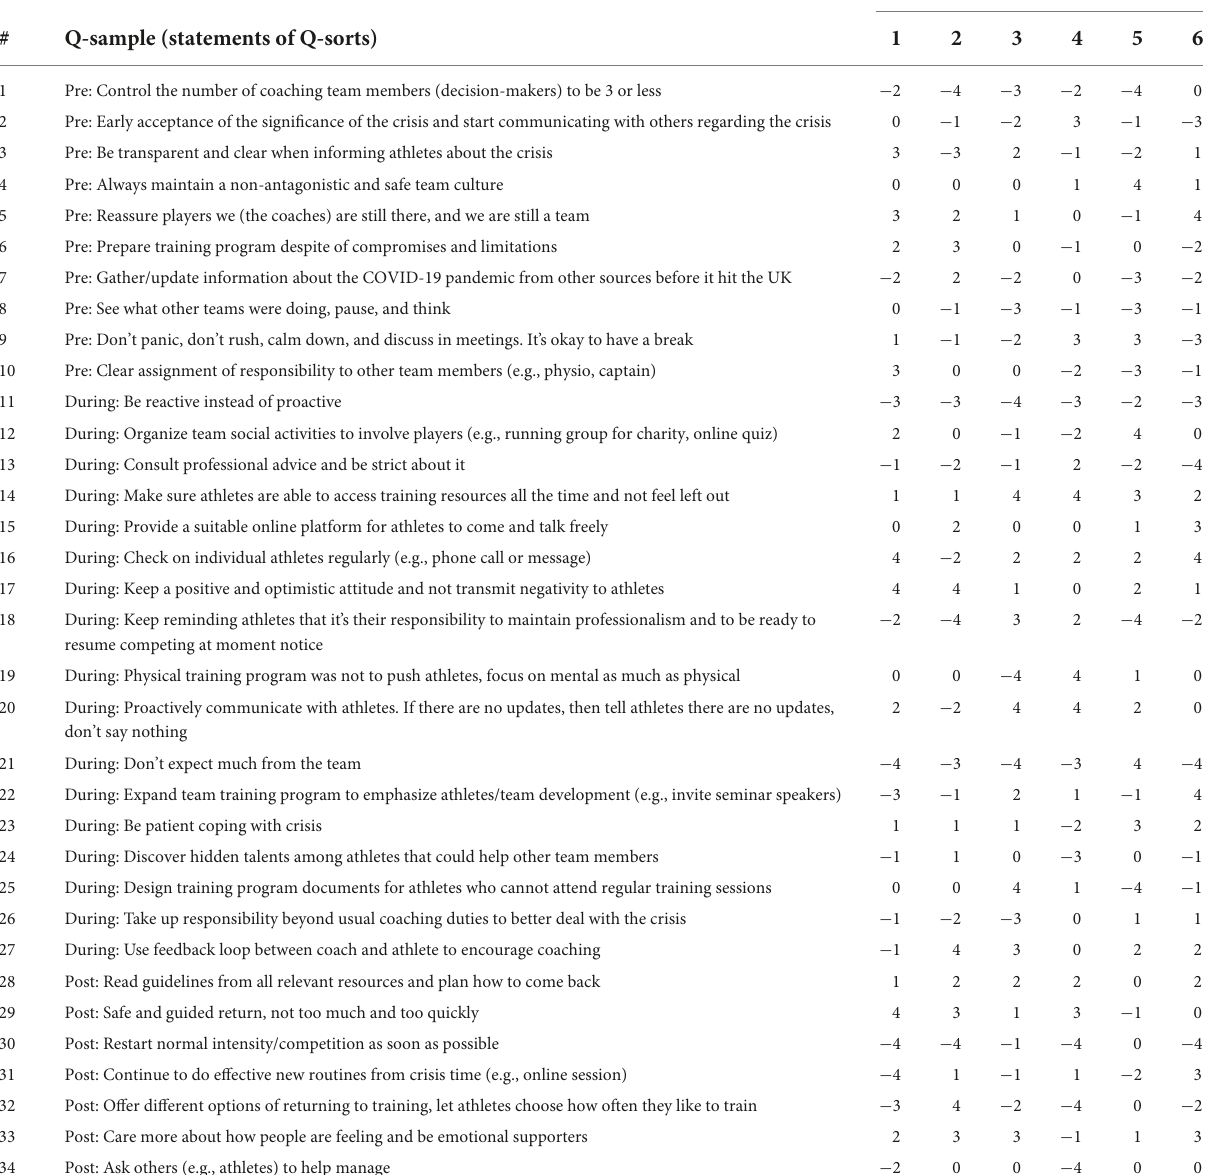
TABLE 1 Statements scores for each